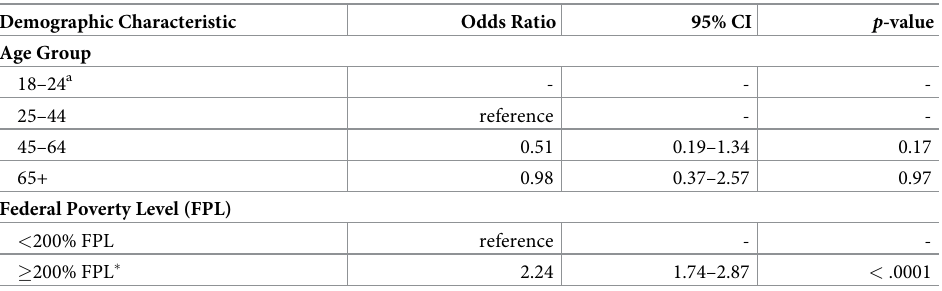
Table 8. Odds of responding to a mail (push-to-web) letter invitation 1, 2 .